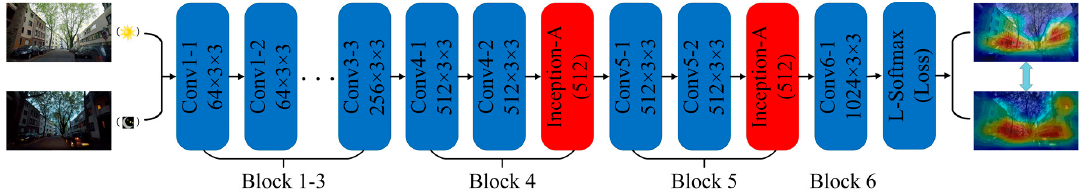
Figure 3. The multi-column network architecture. In the first 3 blocks (including 7 convolution layers), VGG16 pre-trained on ImageNet is used, and the parameters in the rectangle are represented as Conv − (block number) − (layer number) (filter number × filter size × filter size). In the next 3 blocks (also including 7 convolution layers), Inception-A modules are used, and the parameters in the rectangle are denoted as same with VGG16 modules.